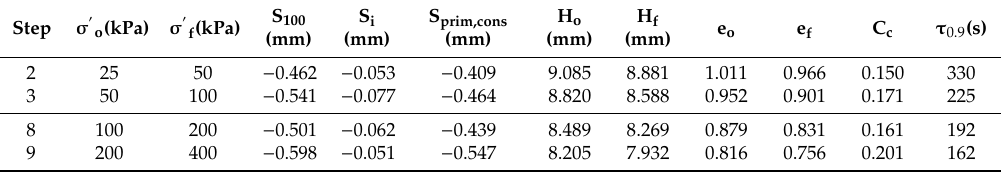
Table 9. Data obtained from compressibility and consolidation curves in kaolinite (steps 2–3 and